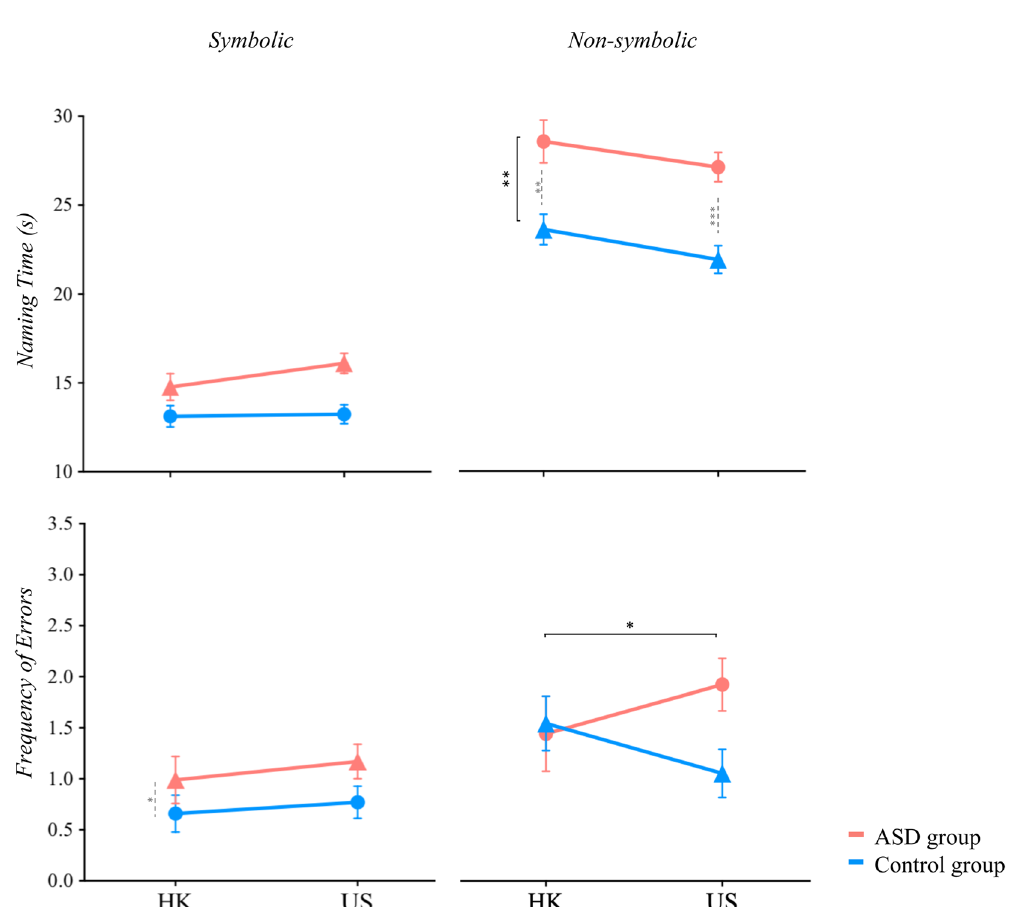
Figure 1. RAN performance (naming time and error rates) across cultures, diagnostic groups, and conditions. A significant diagnosis effect emerged in the non-symbolic condition for naming time ( Estimate = − 4.80 p < .01). Error bars represent standard error of the mean (SEM). For US-ASD versus US-control group comparisons, refer to Nayar et. al., 2018 8 . * p < .05, ** p < .01, *** p < .001. Black overall bars denote significance of the overall model (i.e., group effect, diagnosis effect), and dashed grey lines indicate pair-wise